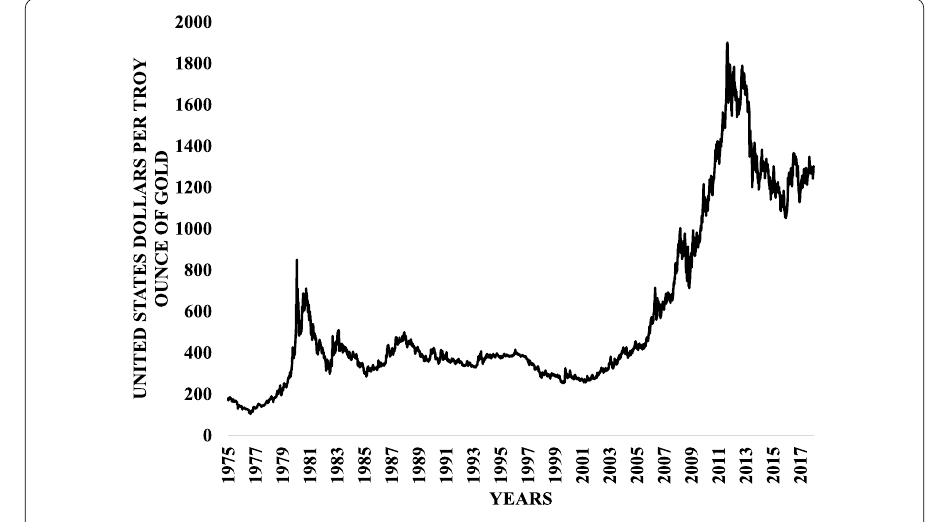
Figure 1 Daily gold spot price from January 02, 1975, to December 29, 2017. Sourceofdata : Bloomberg XAUUSD Currency